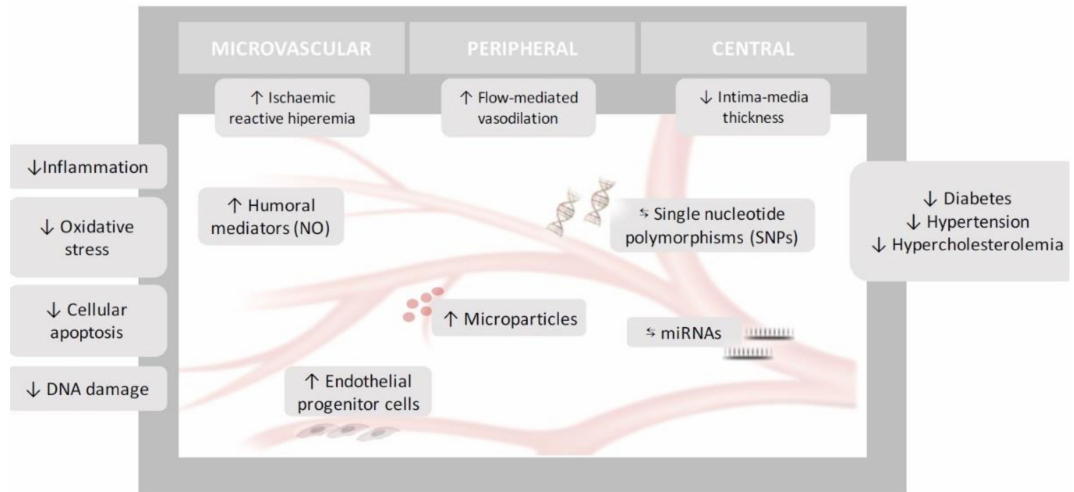
Figure 1. Effects of Mediterranean Diet on Endothelial Dysfunction. ↓ : Decrease; ↑ : Increase; (cid:28) :